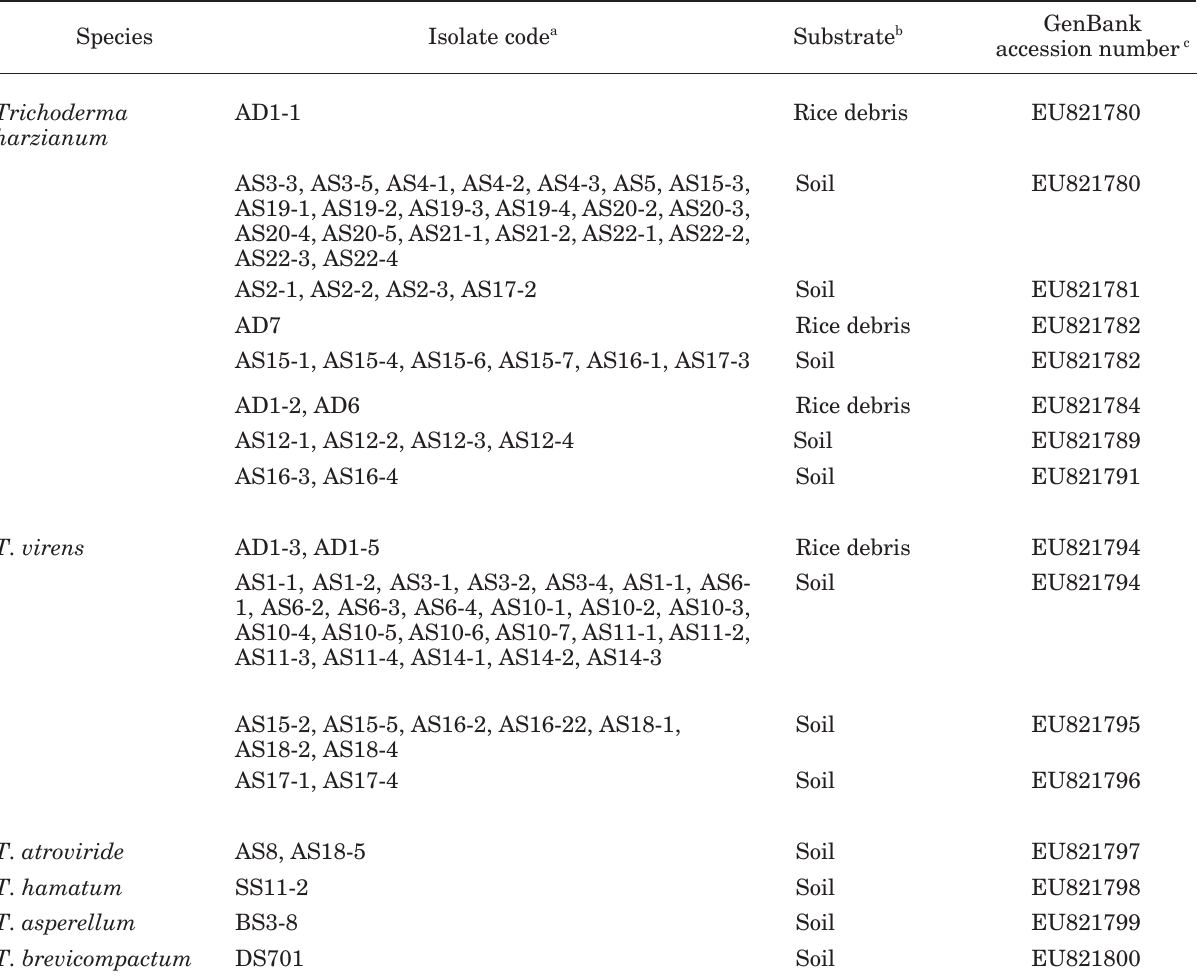
Table 1. Trichoderma strains isolated during this